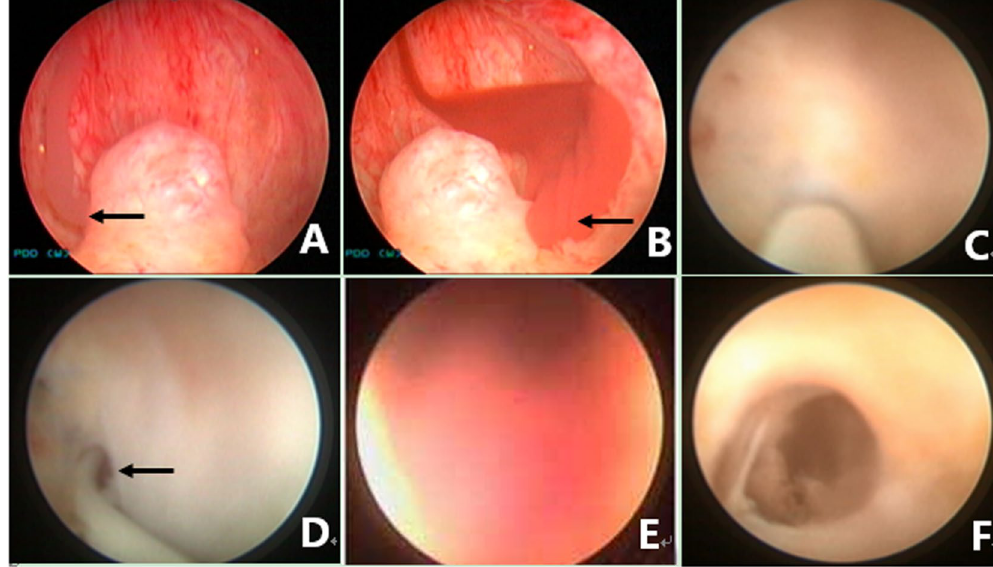
Figure 8. Seminal vesiculoscopy and treatment by fenestration in the PU. ( A ) Endoscopic observation confirmed that the hemorrhage was not located on the right SV because normal jelly-like seminal fluid poured from the right ED orifice upon seminal vesicle massage. ( B ) Bloody fluid poured from the left ED orifice upon seminal vesicle massage, which indicated that the hemorrhage was located in the left SV. ( C ) A translucent membranous weak area was identified at the 4 o’clock position on the posterolateral wall of the utricle. ( D ) The soft tip of a guidewire was inserted along the channel without resistance for 3–5 cm, indicating that the tip had been inserted smoothly into the left SV. ( E ) The seminal vesiculoscope was inserted into the SV under the guidance of a guidewire. The SV was filled with a large quantity of red seminal fluid. ( F ) After irrigation and observation of the SV, the seminal vesiculoscope was withdrawn from the SV upon the formation of an ED short opening.